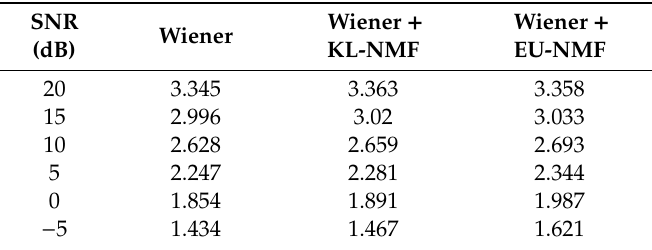
Table 1. The comparison of PESQ scores for the conventional Wiener filter and two di ff erent NNSC cost functions under a babble noise condition.